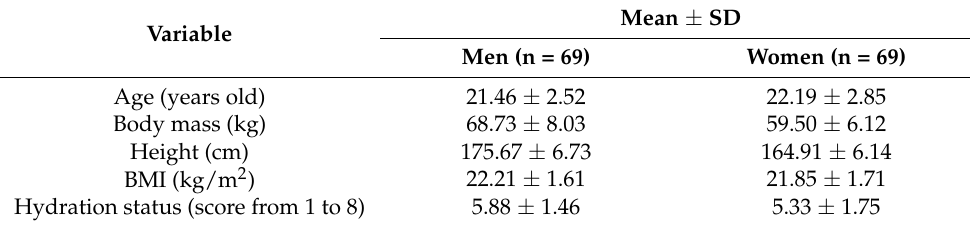
Table 2. Descriptive statistics of the